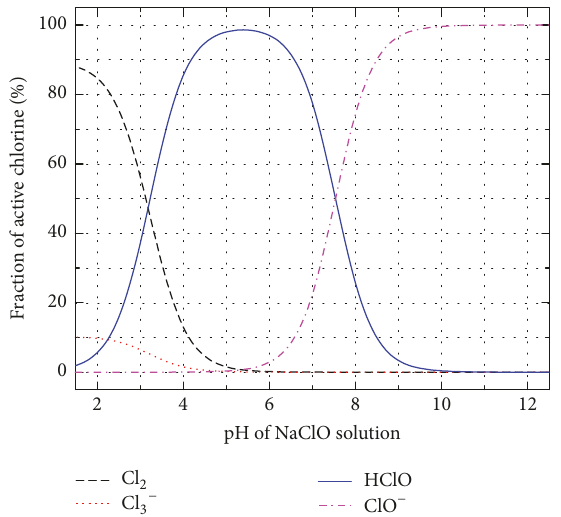
Figure 4: Equilibrium concentrations of active chlorine species in NaClO solution as a function of solution